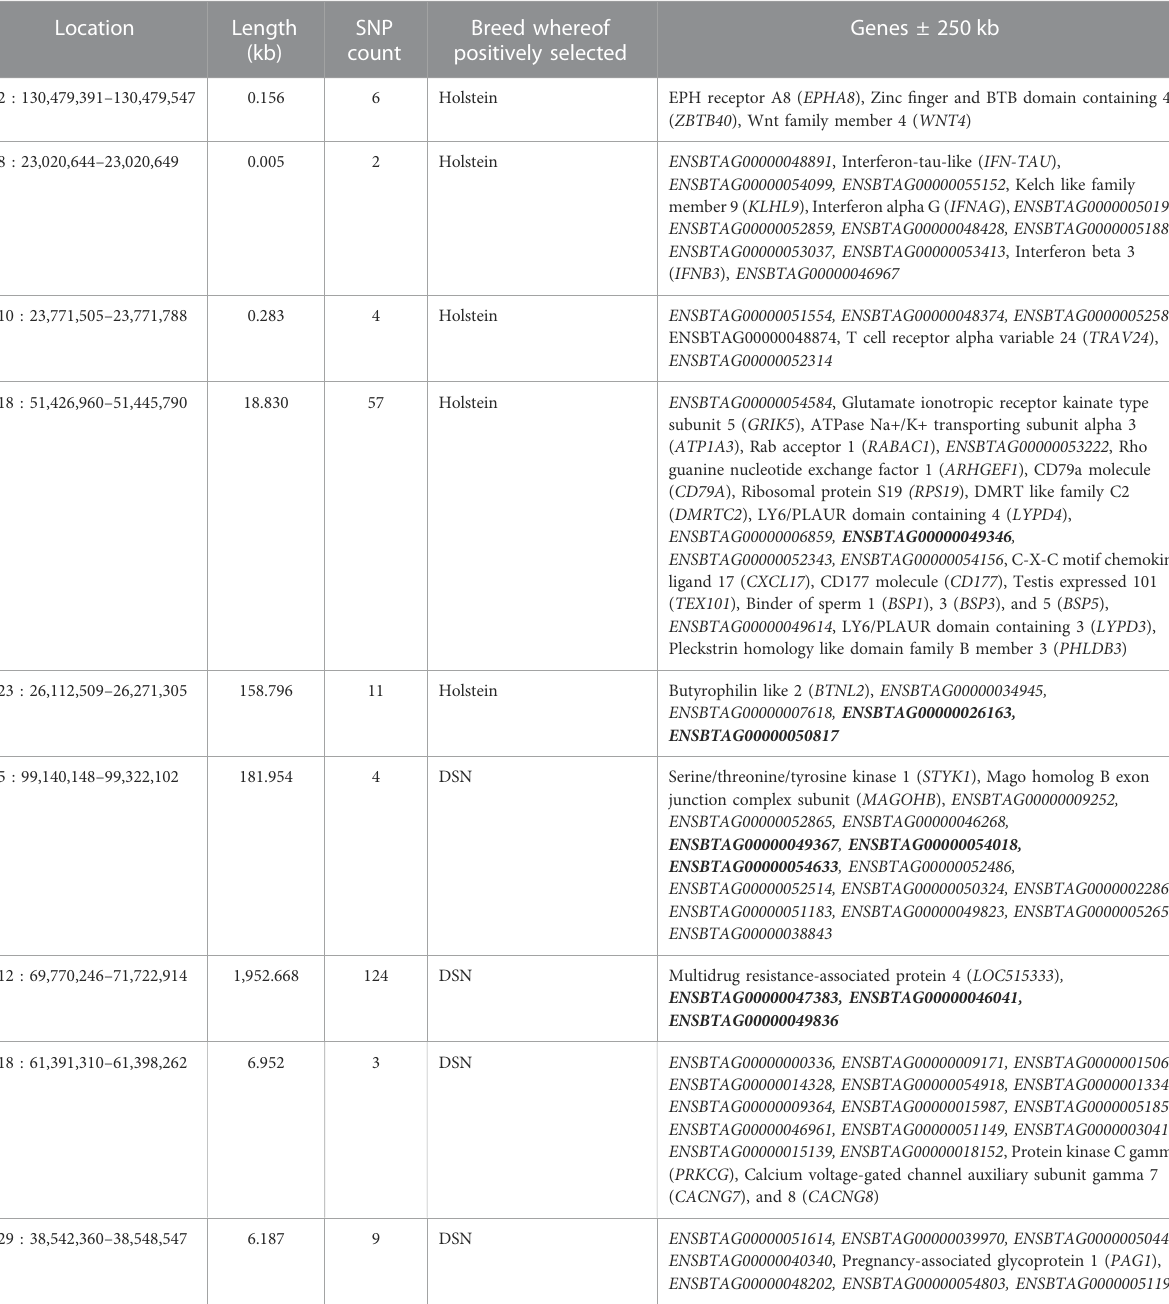
TABLE 3 Positional candidate genes in regions with signi fi cant XP-EHH regions between DSN and Holstein. Genes in bold are located directly within the regions. All other genes are located ± 250 kb from the start and end positions of the regions.